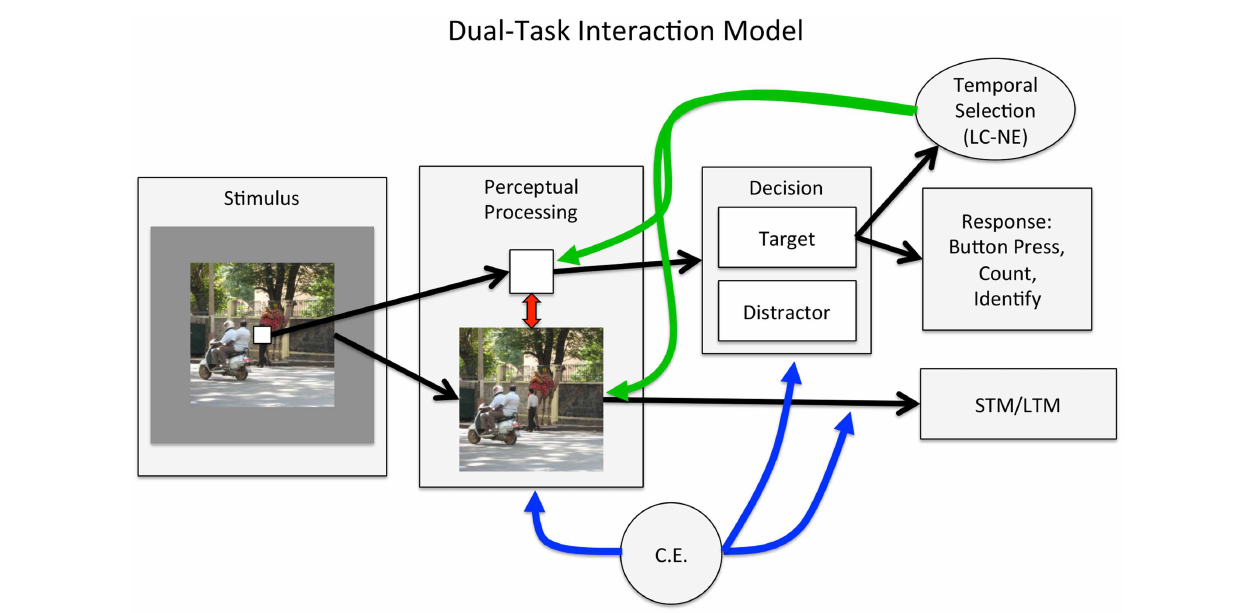
item that requires a response (e.g., counting, holding on to the identity of the item in memory, or generating, or withholding, a planned motor response) triggers temporal selective attention.We propose that temporal selective attention, potentially instantiated by a transient increase in the release of norepinephrine from the locus coeruleus (LC-NE; Nieuwenhuis et al., 2005), is temporally, but not modality or spatially selective. It therefore enhances the processing of all perceptual information that is present when a target occurs. In addition, the detection of a target could reset neuronal activity across regions (Bouret and Sara, 2005; Lakatos et al., 2009).When stimuli are regularly presented, the consequent entrainment of neural activity to